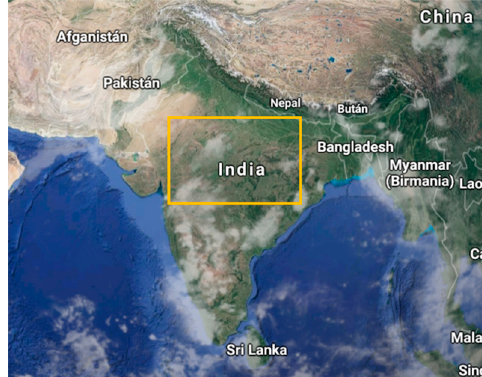
Figure 7. Close up of the area selected for the sensitivity analysis of CyGNSS observables to TWI and SMAP-derived SMC.